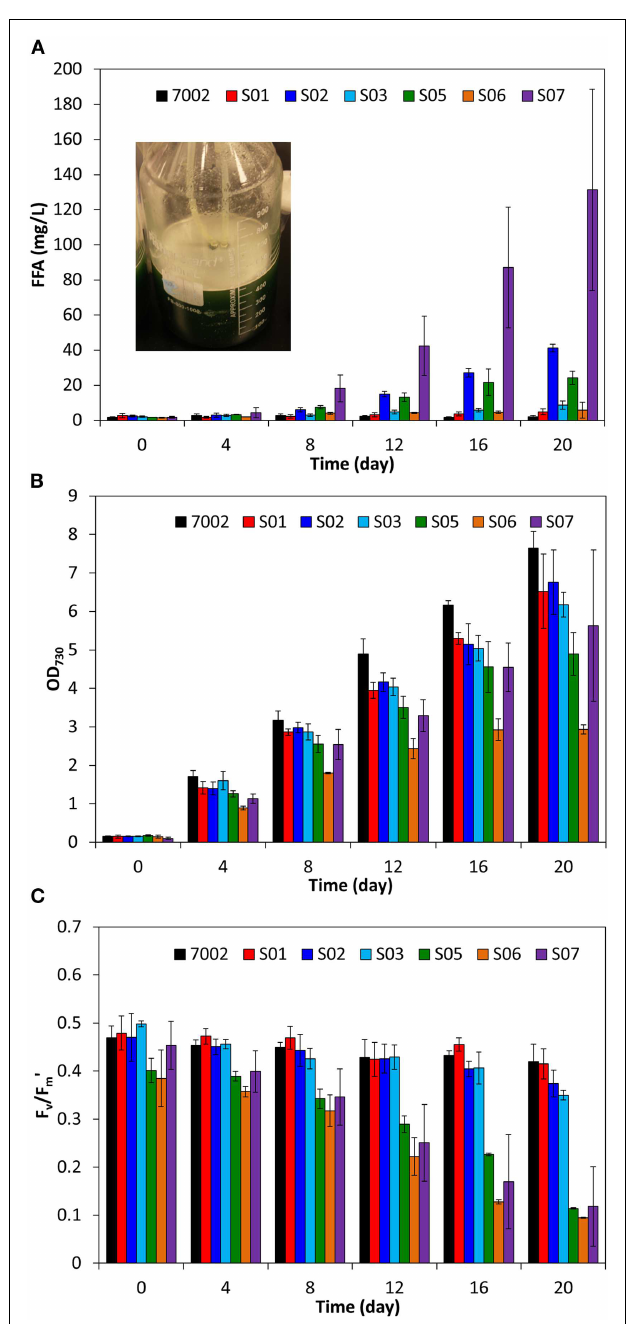
FIGURE 4 | Comparison of extracellular FFA concentration (A), cell concentration (B), and photosynthetic yields (C) during FFA production in engineered Synechococcus sp. PCC 7002 strains .The inset image in plot A shows FFA precipitation and floatation (white precipitate) in S07 cultures after 20days. All data are averages of at least three biological replicates with error bars indicating the standard